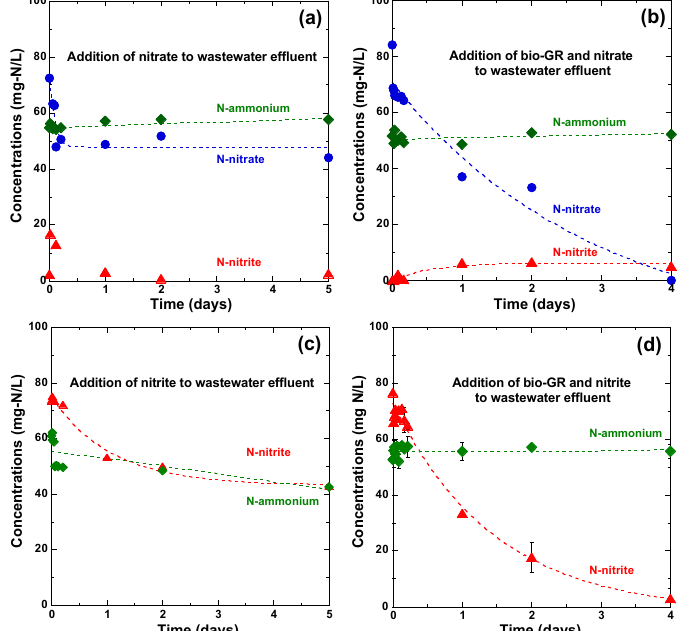
Figure 8. Nitrate and nitrite reduction in wastewater influent by a native wastewater-denitrifying consortium in the absence ( a , c ) or presence ( b , d ) of biogenic Fe(II-III) hydroxycarbonate green rust, referred to as “bio-GR(CO 3 )”. Nitrite (76 ± 2 mg-N L − 1 ) and nitrate (78 ± 8 mg-N L − 1 ) ions were added to wastewater influent that initially contained ammonium concentrations around 55 ± 4 mg-N L − 1 (n = 5). Error bars represent standard deviation. Experimental data of nitrate and nitrite reduction (dashed lines) were fit using a pseudo-first-order kinetic model, while experimental data of ammonium were fit using a linear regression fitting procedure.